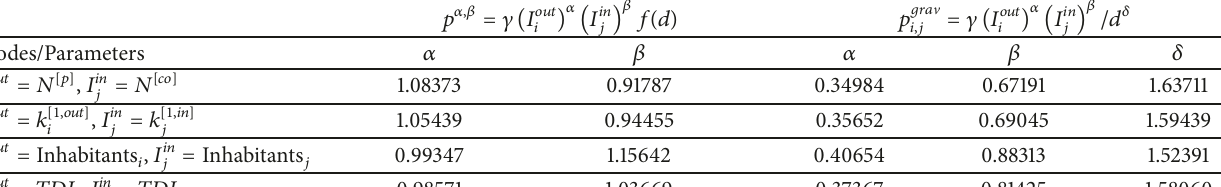
Table 3: Coefficients of the parametric models that reflect the importance of the variables.